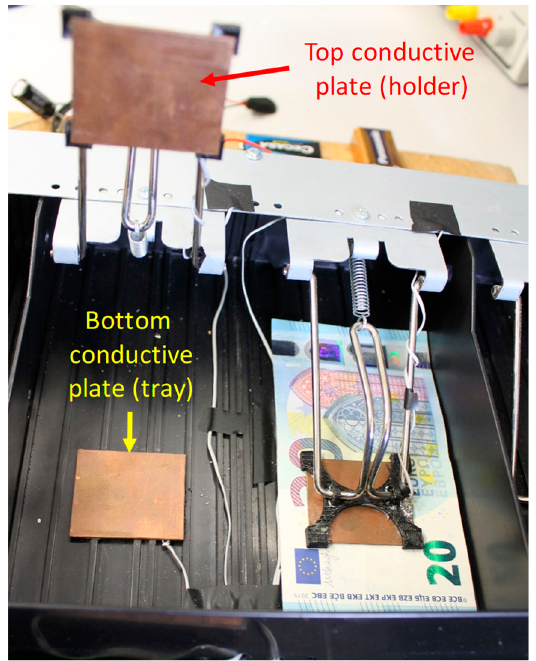
Figure 4. Adapted compartment without banknotes ( left ) and with 20 euro banknotes ( right ).